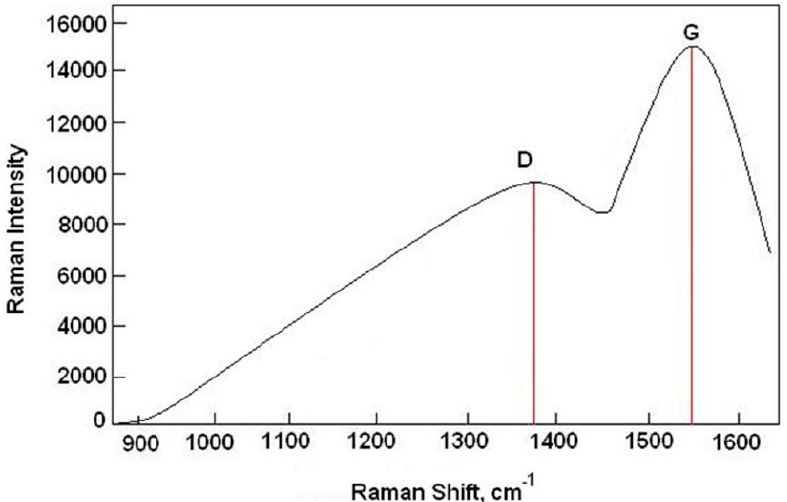
Figure 3. Raman spectrum for the diamond-like carbon coating applied to the surface of S355: D—diamond structure and G—graphite structure.